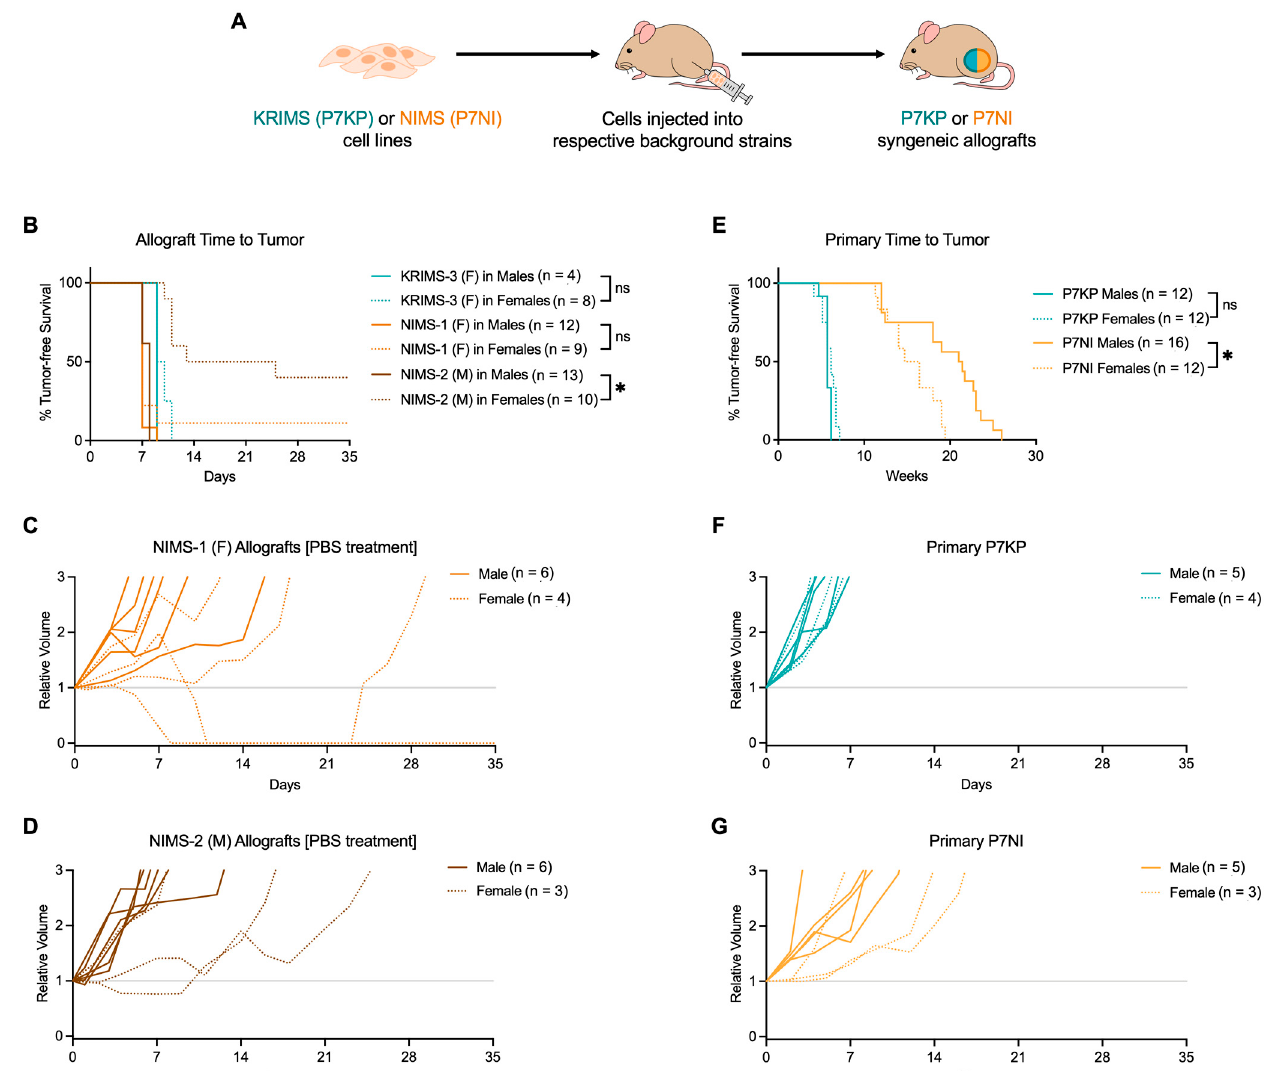
Figure 3. KRIMS and NIMS allograft development and growth. ( A ) KRIMS (P7KP) and NIMS (P7NI) cells were orthotopically implanted into mice of the same respective background strain to develop syngeneic allografts. KRIMS-3 and NIMS-1 cells were derived from tumors in female ( F ) mice, while NIMS-2 cells were derived from a tumor in a male (M) mouse. ( B ) NIMS-2 cells displayed significant sex-dependent differences in tumor initiation. ( C , D ) Individual NIMS-1 and NIMS-2 tumor growth curves. Tumors in females developed later than those in male mice and displayed highly variable growth patterns. ( E ) Reanalysis of data presented in Figure 1B. Tumors in female P7NI mice initiated significantly faster than in male P7NI mice. ( F , G ) Reanalysis of data from Figure 1C. Individual primary P7KP and P7NI tumor growth curves. Log-rank (Mantel-Cox) test with Bonferroni correction used to analyze B (adjusted α = 0.003125) and E (adjusted α = 0.008333). * p < 0.003125 in B; * p < 0.008333 in E. Complete statistical analysis available in Figure S1. * p < 0.05; ns = not significant.